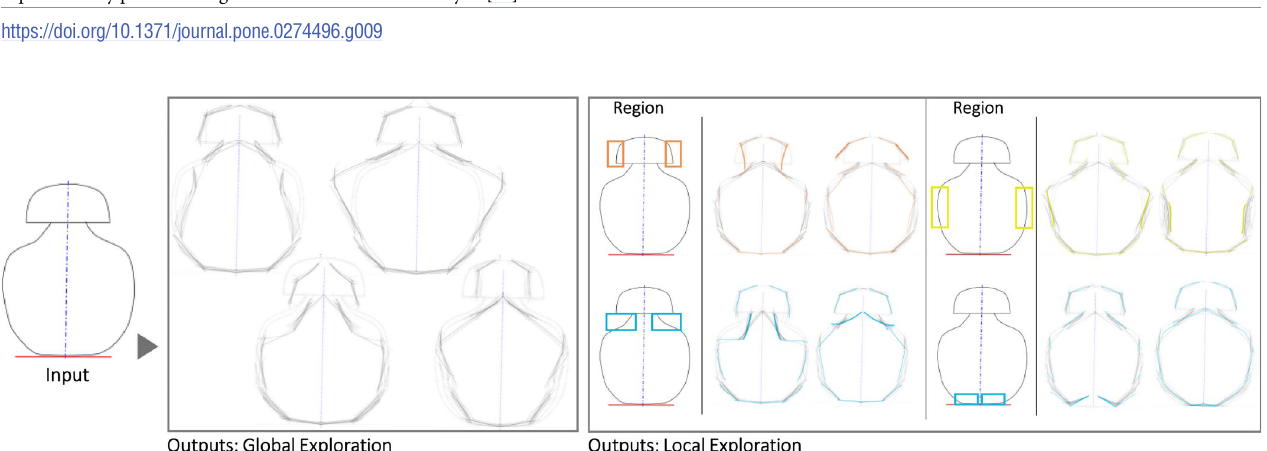
Fig 10. Some of the Global and Local shape variations generated with Shapi for the conceptual exploration of a perfume bottle. The Seed is based on an exploration by an industrial designer [89].